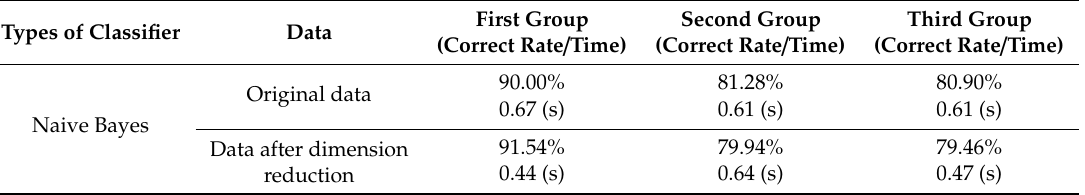
Table 3. Training and detection results for naive Bayes